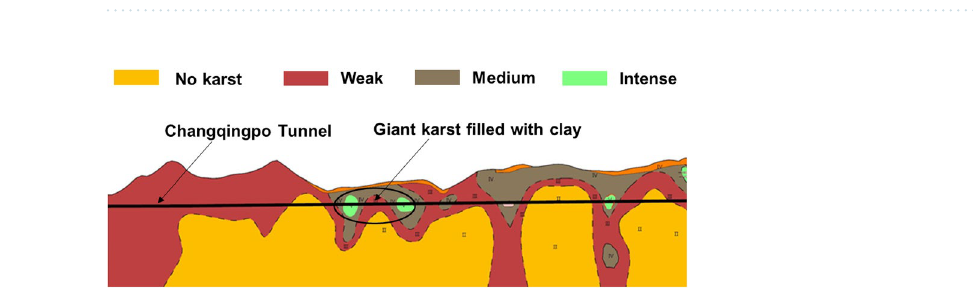
Figure 4. 5-Fold cross-validation process.